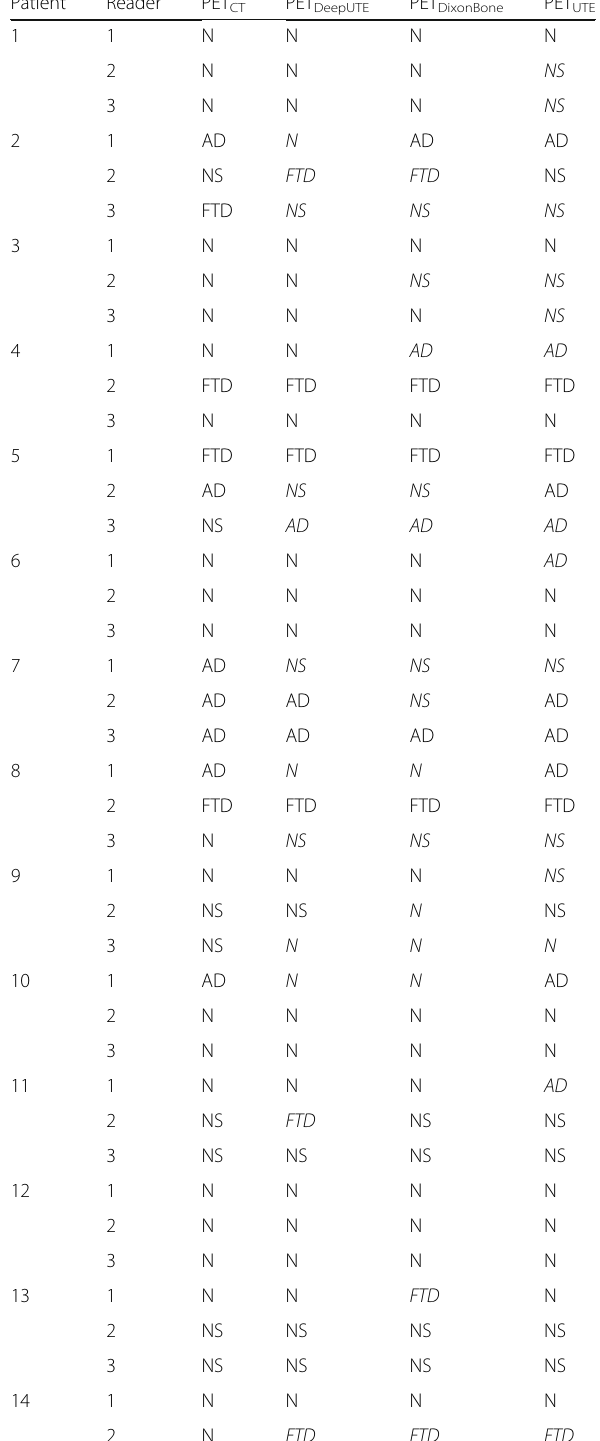
Table 4 Assigned diagnostic categorization for each patient made by three nuclear medicine physicians from PET images with three MRAC methods (PET DeepUTE , PET DixonBone , PET UTE ) and PET CT . Cerebellum was used as reference region. Intra-reader discrepancies with PET CT as reference are italicized Patient